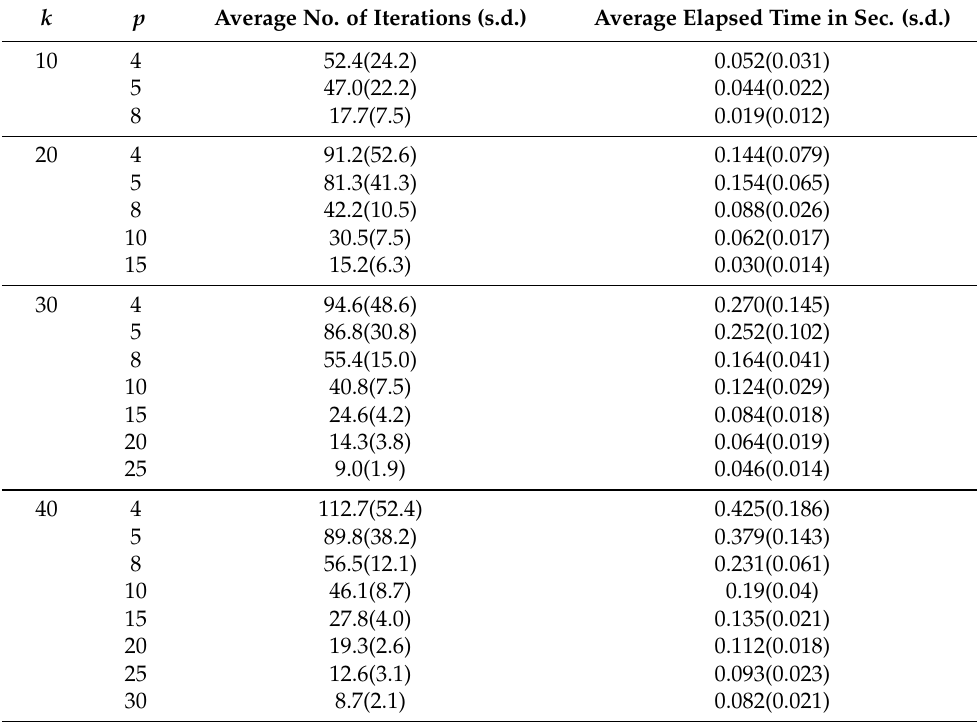
Table A6. The average number of iterations and average elapsed time of the EA -optimal